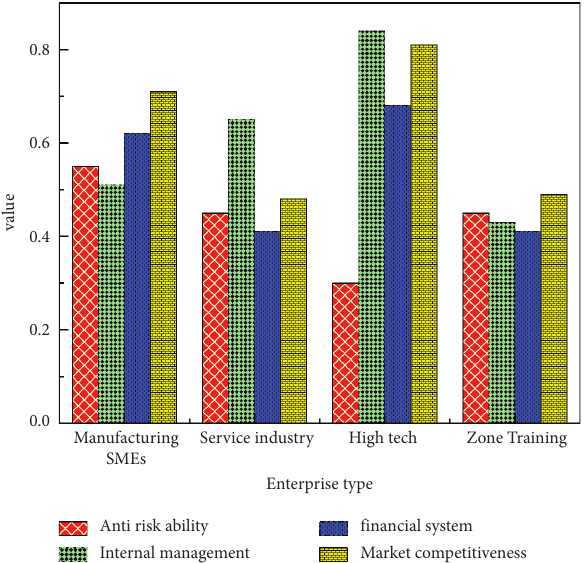
Figure 3: Financing factor values of different